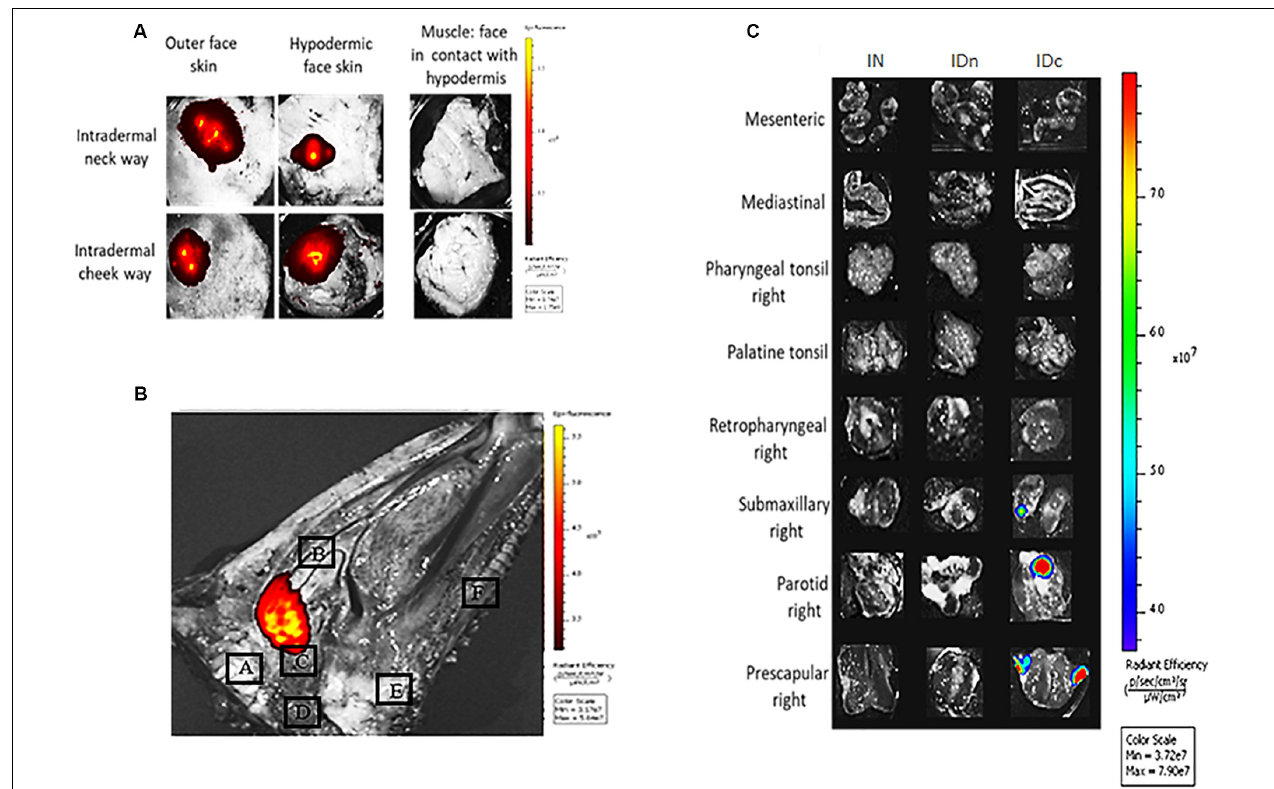
FIGURE 2 | Ex vivo tracking of DGNP-DiR administered by intranasal spray or by intradermal inoculation in the neck or in the cheek. DGNP-DiR signal was observed 24 h after administration using the in vivo imaging system IVIS R (cid:13) Spectrum (PerkinElmer) under epi-illumination with filters set: 745 nm ex/800 nm em (A) Inoculation sites from sheep inoculated with DGNP-DiR by intradermal routes. (B) Sagittal cut of head from sheep inoculated with DGNP-DiR by nasal route A: Brain B: Turbinate C: Tubal tonsil D: Medial retropharyngeal lymph node E: Palatine tonsil F: Palate. (C) Lymph nodes from sheep inoculated with DGNP-DiR by nasal (IN), intradermal neck (IDn), or intradermal cheek (IDc)